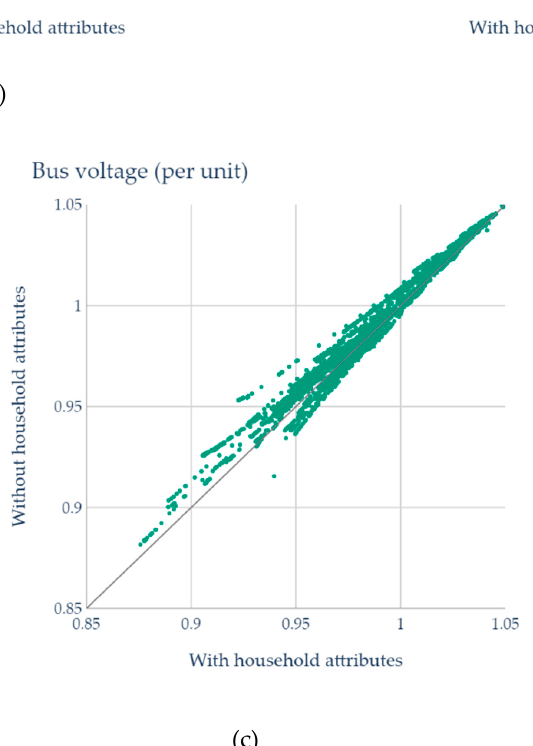
Figure 12. Comparison of median ( a ) line loadings, ( b ) transformer loadings and ( c ) bus voltages based on charging point allocations with and without consideration of household attributes in 62 grids and 50 spatial allocation